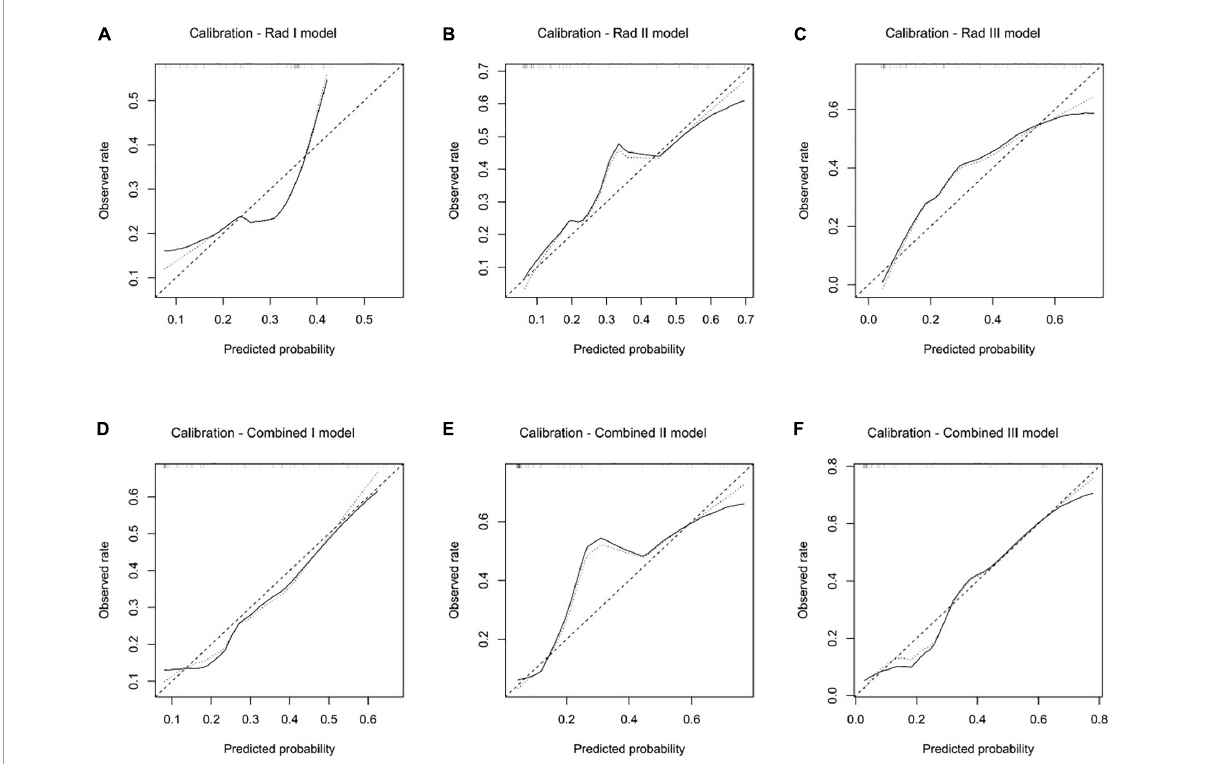
FIGURE7 Calibration analysis of the Rad I model (A) , Rad II model (B) , Rad III model (C) , Combined I model (D) , Combined II model (E) , and Combined III model (F) in the validation